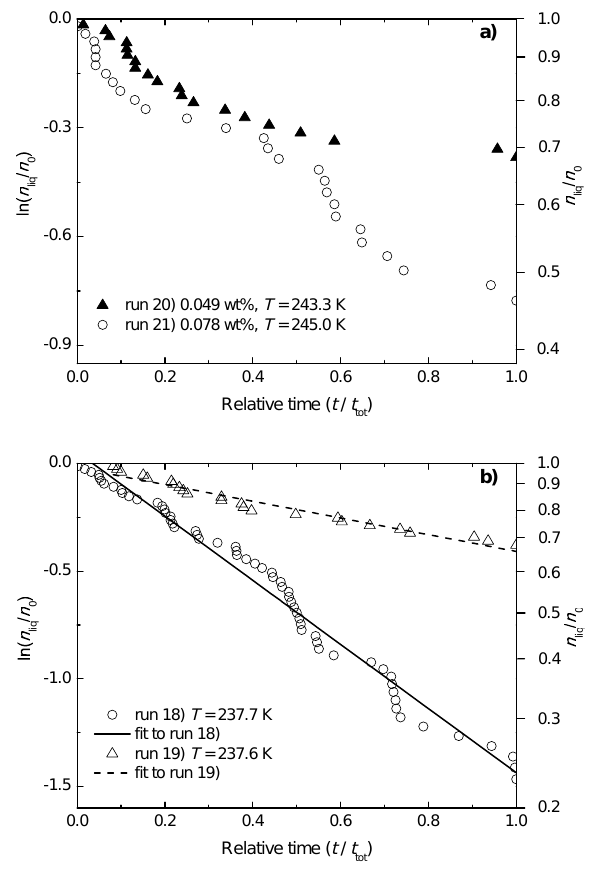
Fig. 7. (a) The decrease in the fraction of droplets which were liq- uid ( n liq / n 0 =1– n ice / n 0 ) with relative time at constant temperature, where n 0 is defined as the number of liquid droplets at the begin- ning of the isothermal experiment (i.e. excluding any droplets which froze during cooling to the isothermal temperature). The relative time is defined as t / t tot where t tot is the total time the droplets were held at constant temperature. Two heterogeneous isothermal ex- periments are shown for two different temperatures (uncertainty is ± 0.6K) and concentrations. The numbering in the key corresponds to the information in Table 3. For runs 20 and 21, t tot =646s and 853s, respectively. (b) Two homogeneous experiments for compar- ison. The straight lines are linear fits to the homogeneous data. For runs 18 and 19, t tot = 2727s and 222s, respectively.